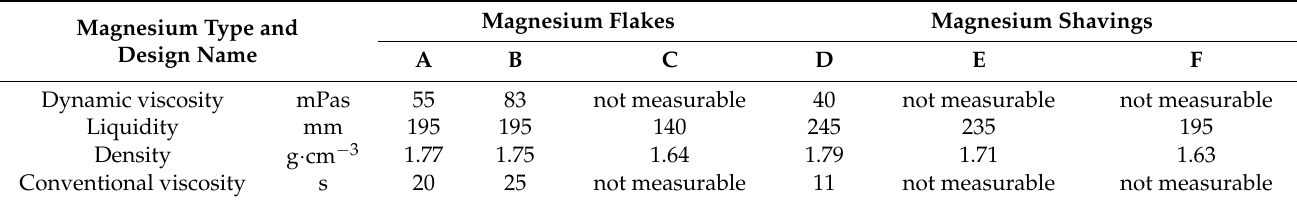
Table 2. Parameters of fresh sealing